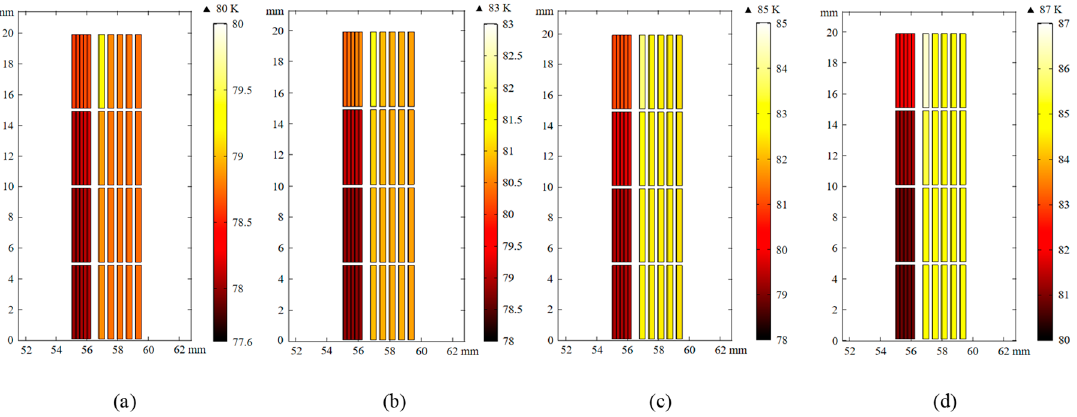
Figure 11. Temperature distribution of primary and secondary windings at ( a ) 0.02 s, ( b ) 0.04 s, ( c ) 0.06 s, and ( d ) 0.08 s.